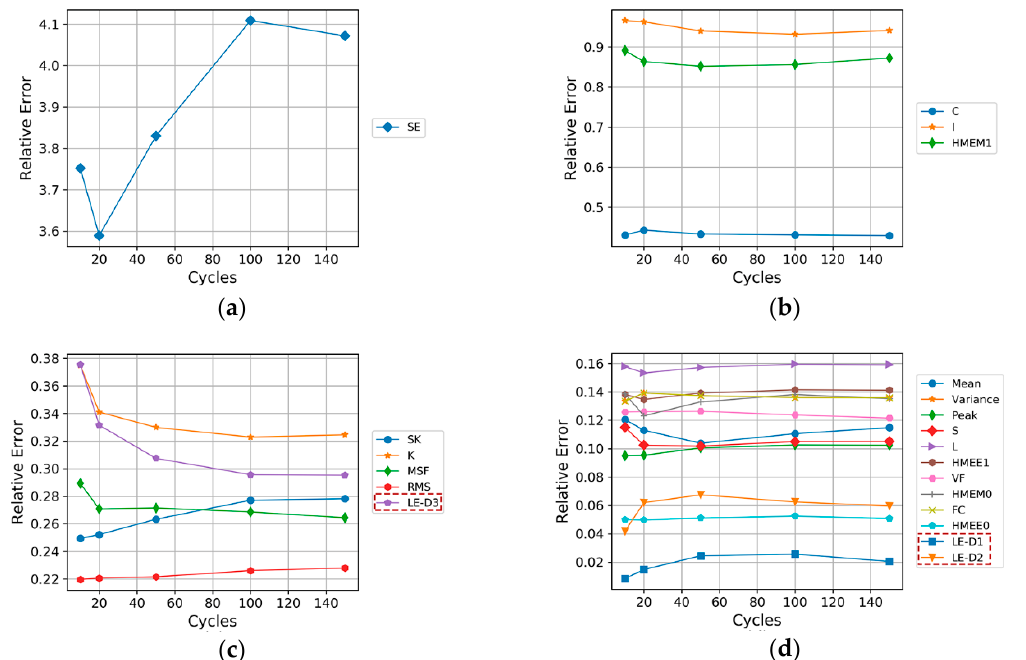
Figure 14. Comparison of prediction errors of characteristics type: ( a ) more than 3.5, ( b ) between 0.4 and 1, ( c ) between 0.2 and 0.4, ( d ) between 0.01 and 0.2.